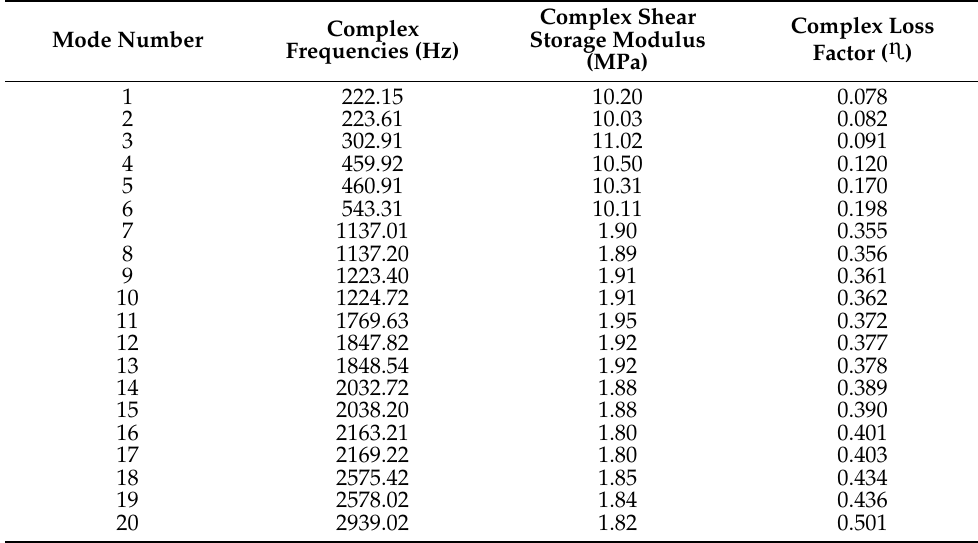
Table 8. Wheel complex natural frequencies, shear storage modulus and loss factor.